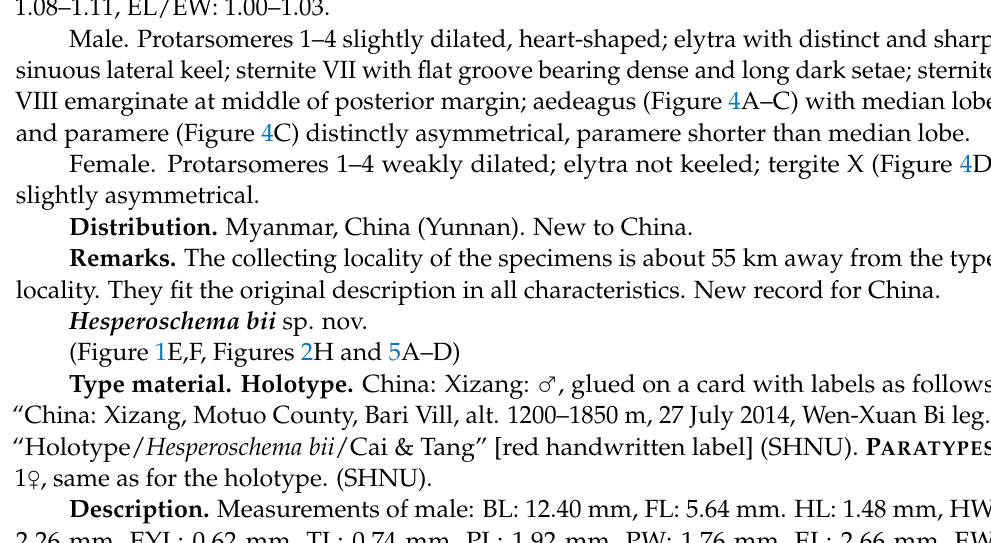
Distribution. Myanmar, China (Yunnan). New to China.